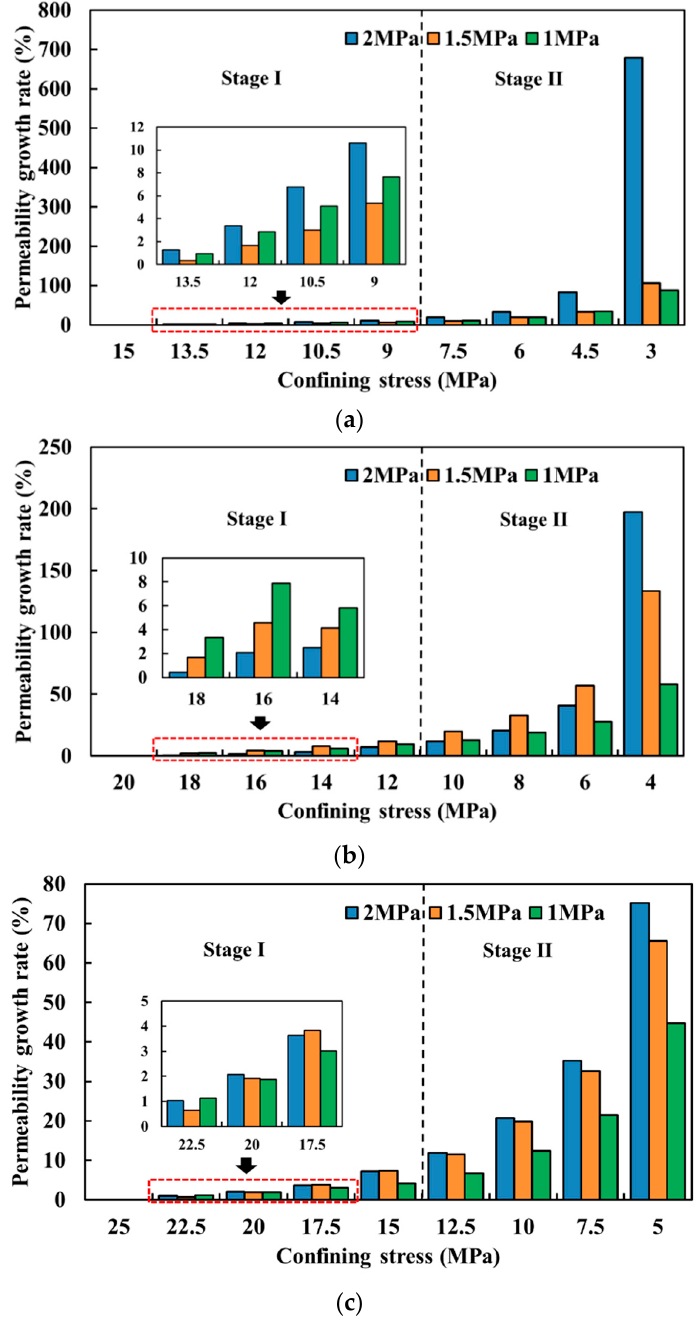
Figure 10. Permeability change ratio variation of sandstone under different initial confining pressures (( a – c ) are the initial confining pressure of 15 MPa, 20 MPa, and 25 MPa,